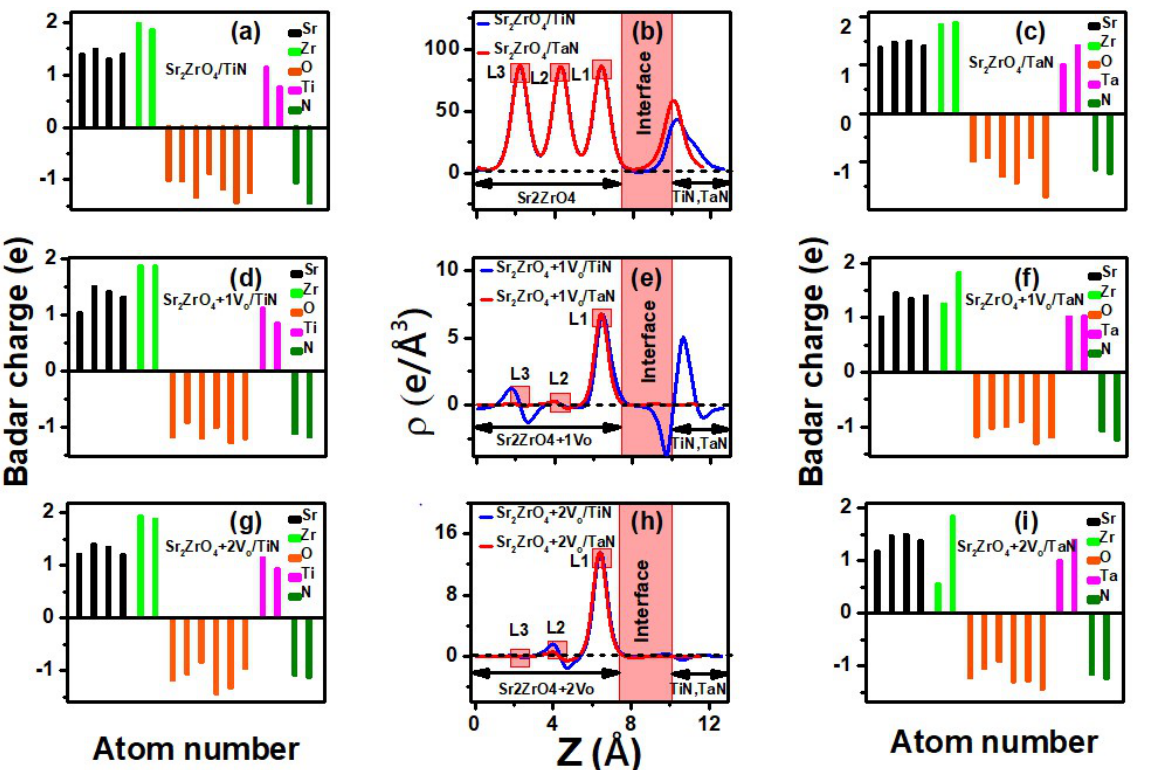
Figure 6. Integrated charge density plots in middle panel and their respective Bader charge analysis in left and right panel for ( a – c ) pristine ( d – f ) pristine + 1V o ( g – i ) pristine + 2V o 2D layered RP perovskite structures.